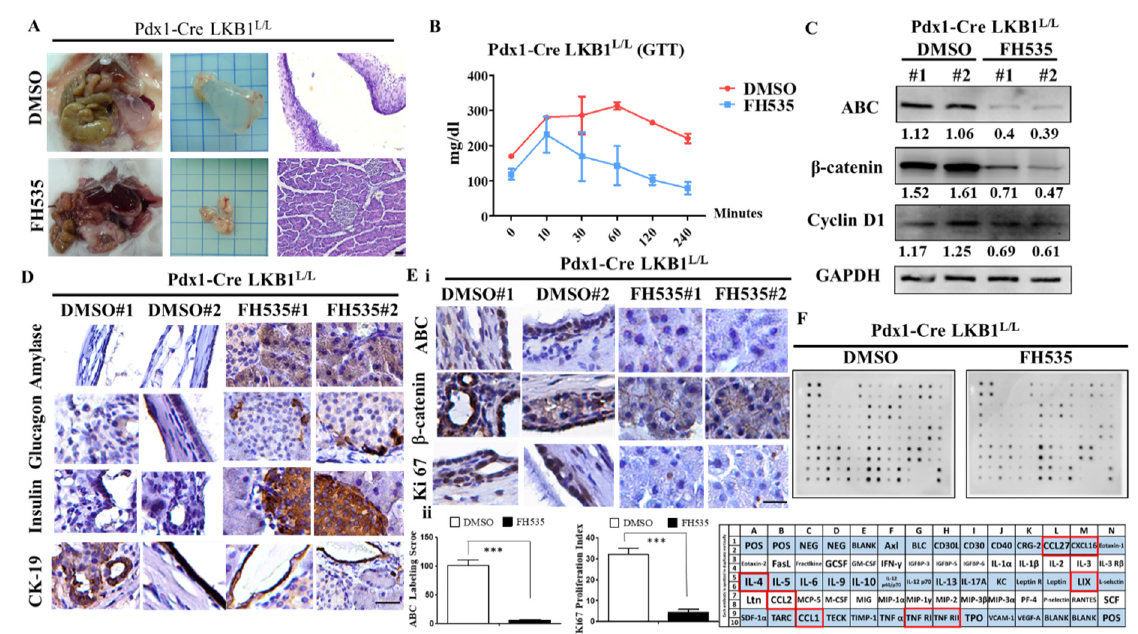
Figure 5. FH535 inhibits pancreatic cystic tumor formation in Pdx-1CreLKB1 L/L mice. ( A ). Gross anatomy of the pancreas and H&E stained examination of the pancreata of Pdx-1Cre LKB1 L/L mice at 12 weeks of age, with or without FH535 treatment. Scale bar is 100 µm. The bottom panel of the FH535 group exhibits a completely normal pancreas architecture and function. ( B ). Twelve-week-old Pdx-1CreLKB1 L/L mice received FH535 treatment that restored the blood glucose concentration to normal (<100 mg/dL) after 2 h, as determined by a GTT test. p < 0.01. ( C ). Western blotting analysis revealed that the treatment of FH535 in Pdx-1Cre LKB1 L/L mice results in decreasing protein levels of total β -catenin, ABC, and Cyclin D1. GAPDH served as a loading control. Relative densitometric values are provided below the blot images. ( D ). Immunohistological sections from 13-week-old Pdx1-Cre LKB1 L/L and Pdx1-Cre LKB1 L/L β -catenin L/L mice stained with antibodies against insulin, glucagon, and amylase and CK19. Scale bar is 100 µm. ( E ). ( i ) IHC staining for β -catenin and Ki67 in pancreata from Pdx-1CreLKB1 L/L mice versus Pdx1-Cre β -catenin L/L LKB1 L/L mice. Scale bar is 100 µm. ( ii ) active β -catenin (ABC) labeling score and Ki67 positive cells were quantified per field. Values given are the means ± SE from 6 random sections for each group. *** p < 0.001. ( F ). Mouse cytokine array analysis of pancreas tissue lysate isolated from Pdx-1CreLKB1 L/L mice versus Pdx1-Cre β -catenin L/L LKB1 L/L mice. Template alignment of the mouse cytokines in the array represented below. The significantly reduced levels of cytokine/chemokine after FH535 treatment are highlighted with red boxes. POS: positive control; NEG: negative control.